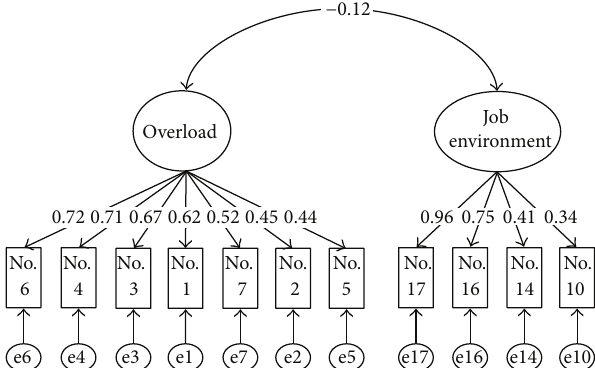
Figure 1: Two-factor structure; model 1. 𝜒 2 /df ratio = 2.49 (107.63/43, 𝑃 < 0.01 ), GFI = 0.94, AGFI = 0.91, CFI = 0.92, RMSEA =